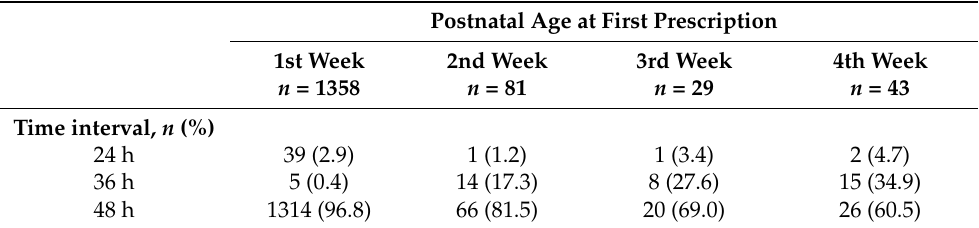
Table 3. Distribution of time intervals between gentamicin doses in 1511 extremely preterm infants (22–26 weeks) according to postnatal age at first prescription.